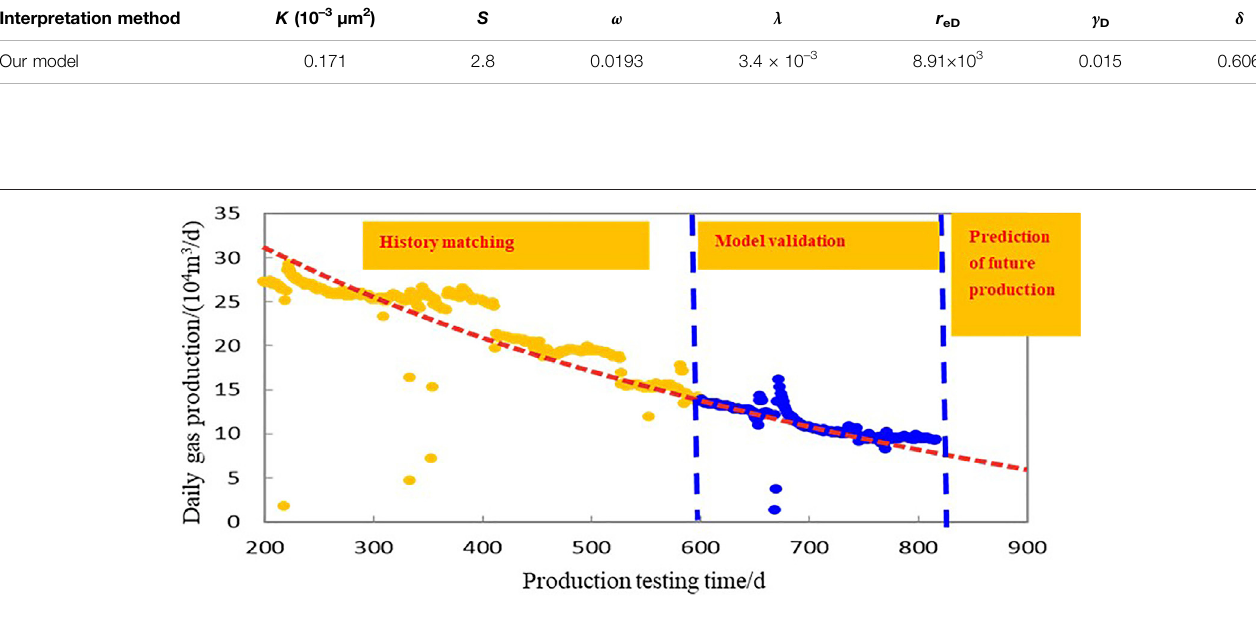
FIGURE 8 | Production prediction of Well M2.